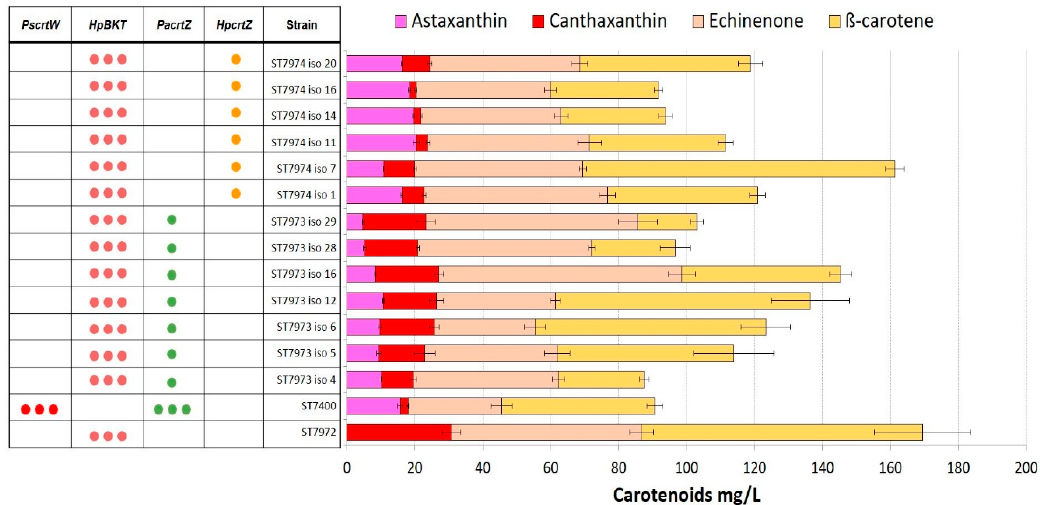
Figure 4. Carotenoid production by strains ST7973 and ST7974. Set of transformants expressing HpBKT in combination with either PacrtZ or HpcrtZ . Positive control: ST7400. Parent strain: ST7972. All strains were cultivated in YP + 8% glucose in 24-deep-well plates for 72 h. Three dots represent multiple integrations of genes, and one dot represents single integration. The error bars represent standard deviations calculated from triplicate experiments (“iso” after each strain indicates the isolate number).